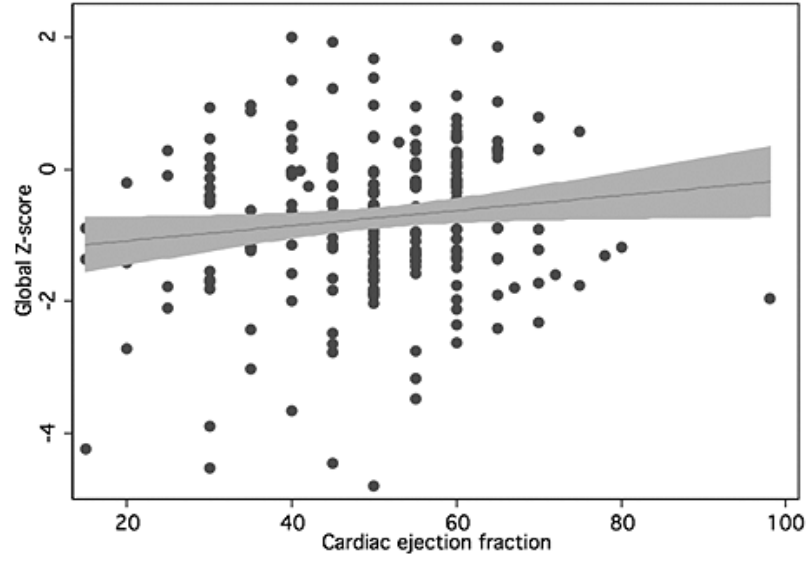
Fig. 1. Linear plot of relationship between Z-score and cardiac EF. Actual data points, linear fit, and 95% confidence bands are shown.